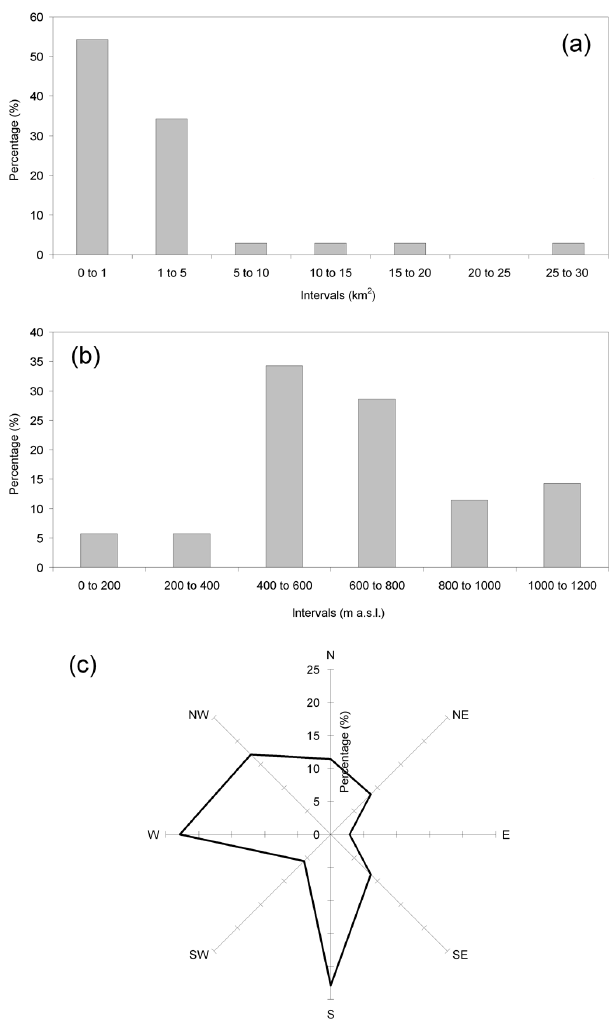
Fig. 9. Distribution of the 35 observed land-terminating GIC: (a) size; (b) mean elevation; and (c) aspect.